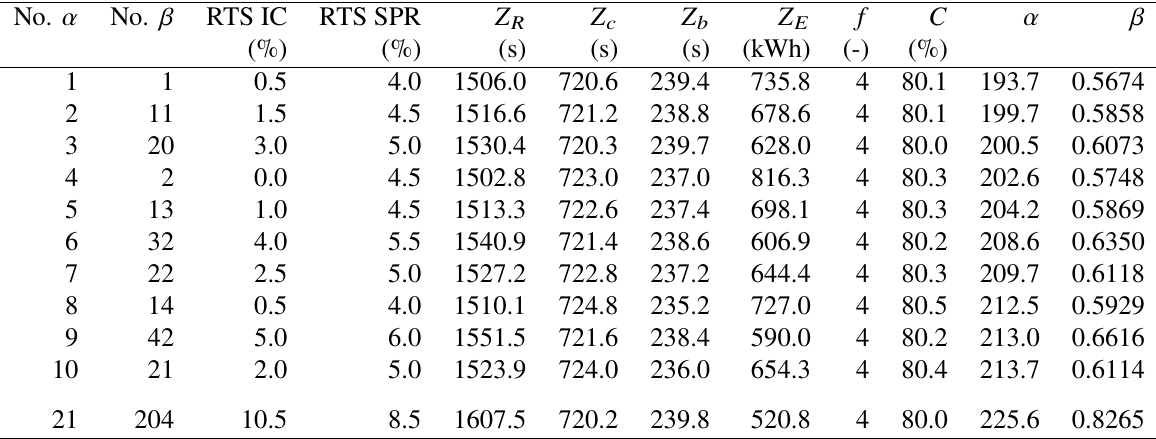
Table 2: First 10 Pareto-optimal solutions and NS constrained optimal solution (No. 𝛼 21) with 30 s minimum buffer time considering the objectives total running time 𝑍 and buffer time 𝑍 for the real-world case Ah-Nm using the weighted sum method (sorted 𝑍 𝑐 𝑏 from low to high according to 𝛼